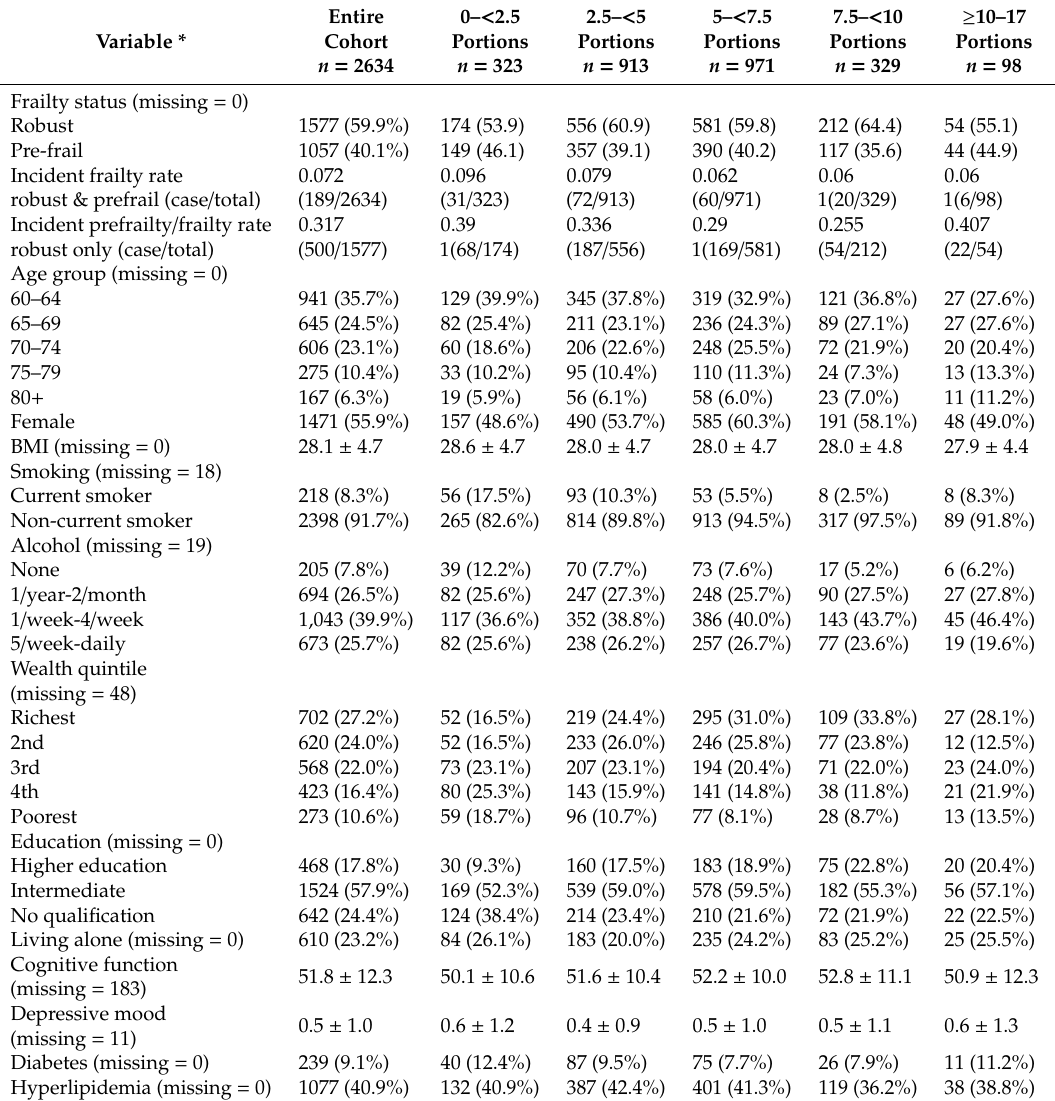
Table 1. Baseline characteristics and incident prefrailty and frailty among 2634 non-frail (prefrail